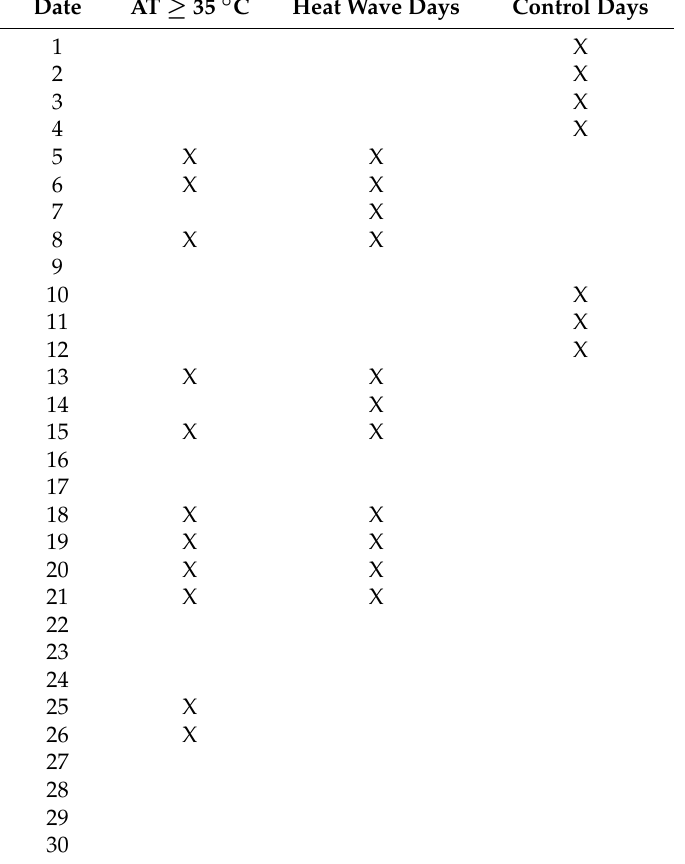
Table 2. Example of heat wave and control definitions for a hypothetical month. An “X” indicates which days meets the related